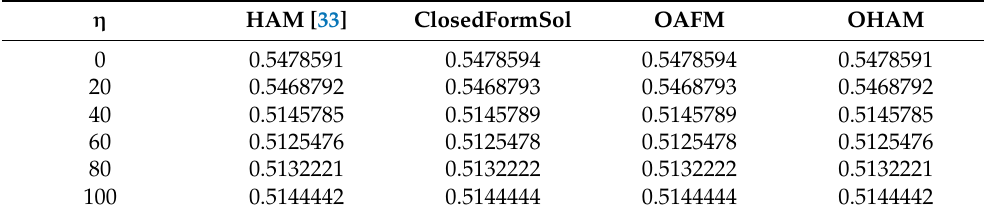
Table 1. Comparison of solutions for f ( η , t ) at α = 1.